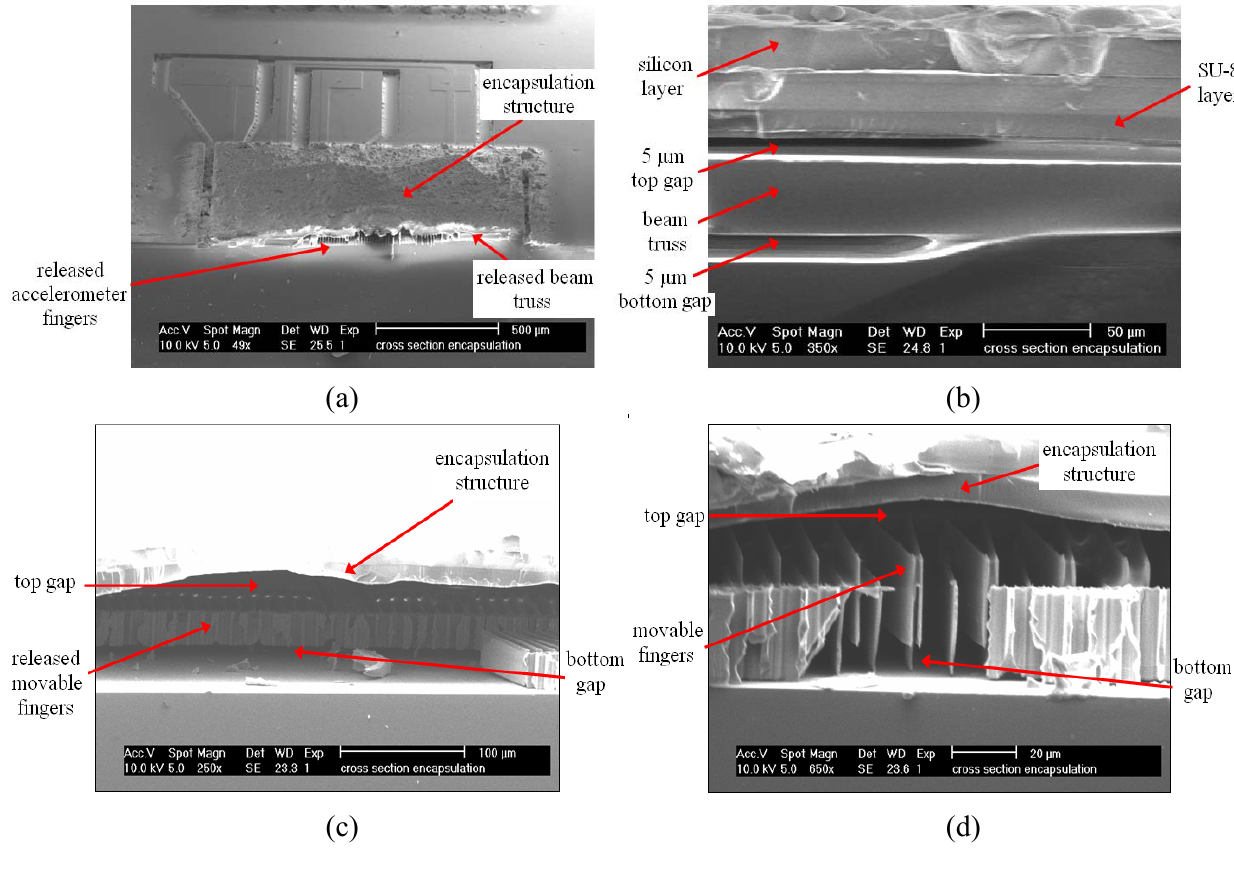
Figure 6. SEM micrograph showing (a) 60° view of an encapsulated MEMSTech 50g accelerometer broken through section A-A of Figure 5, (b) released beam truss, (c) released movable fingers, and (d) close-up view of released stationary and movable